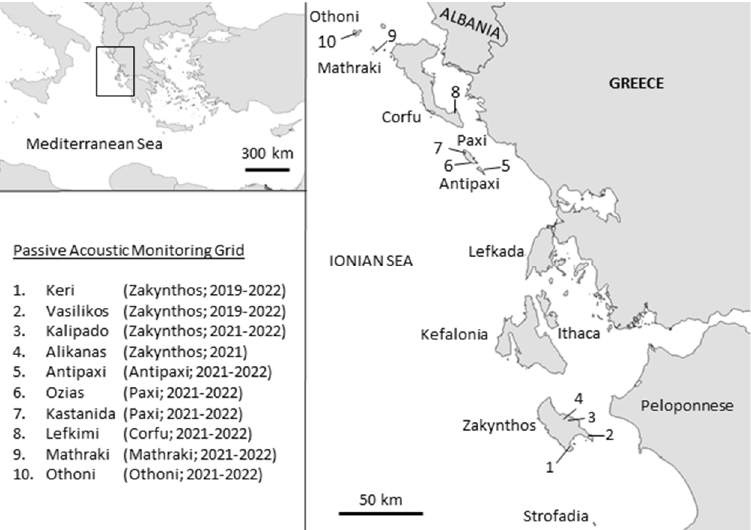
Figure 1. Location, name, and years of operation of the passive acoustic monitoring grid sensors in the Ionian Islands.